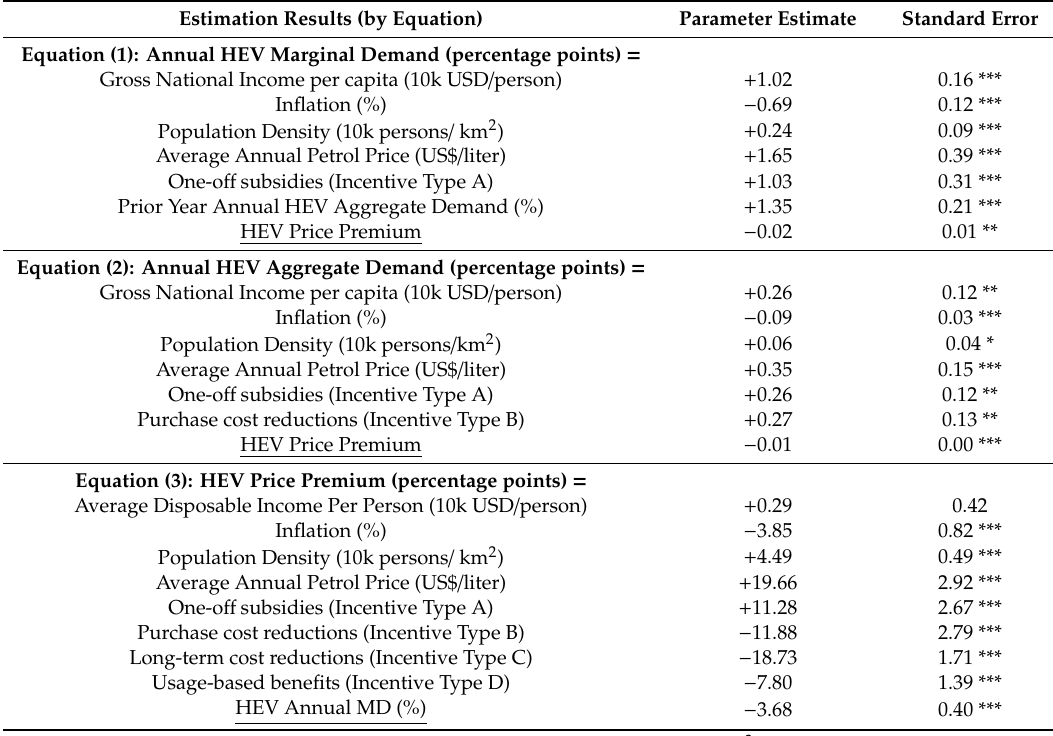
Table 3. Estimation results from EC3SLS